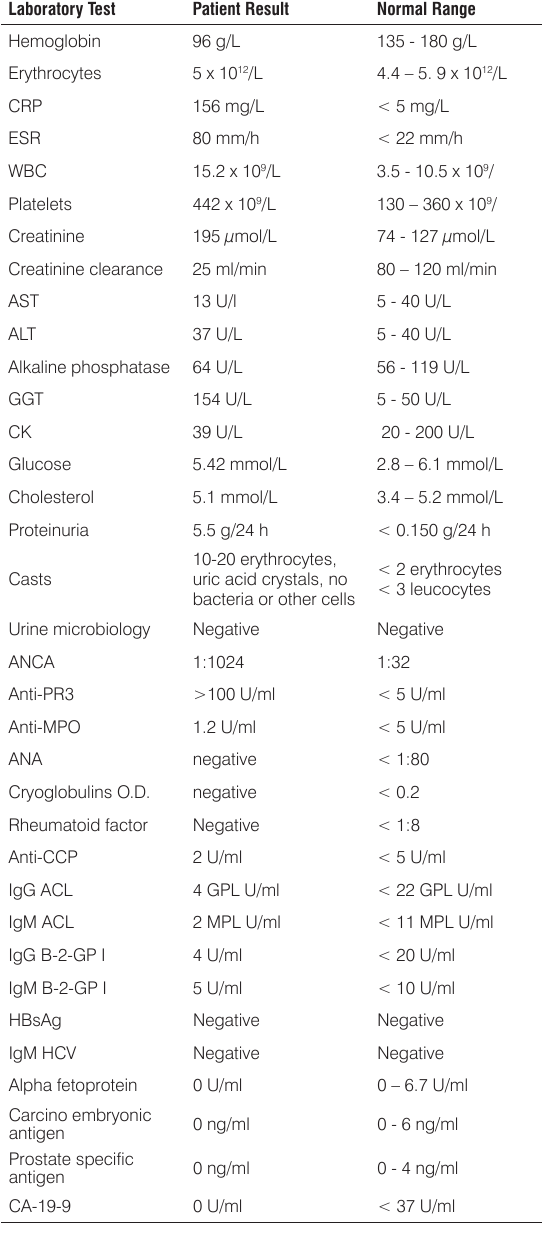
Table 1. Laboratory data.